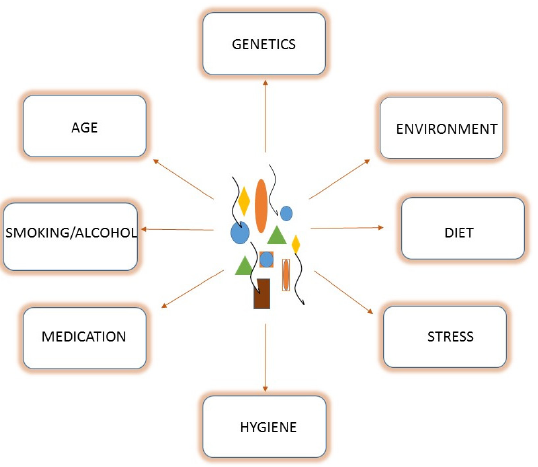
Figure 1. Microbiota diversity and richness are strongly influenced by the host and environmental factors.